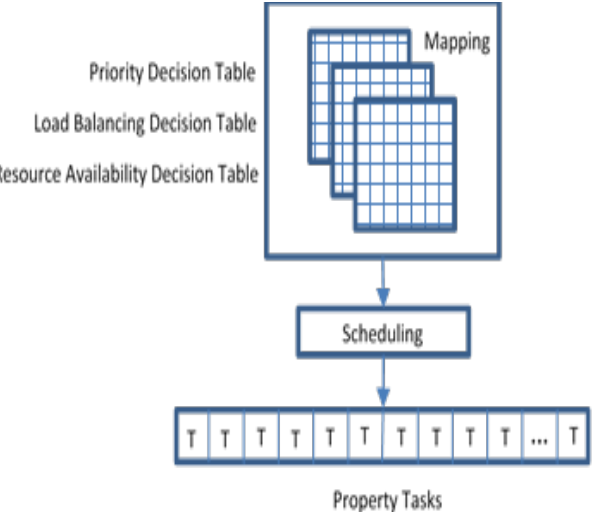
Figure 8. Multi-Agent System (MAS) role in Multi-Agent Fog Computing (MAFC) model.